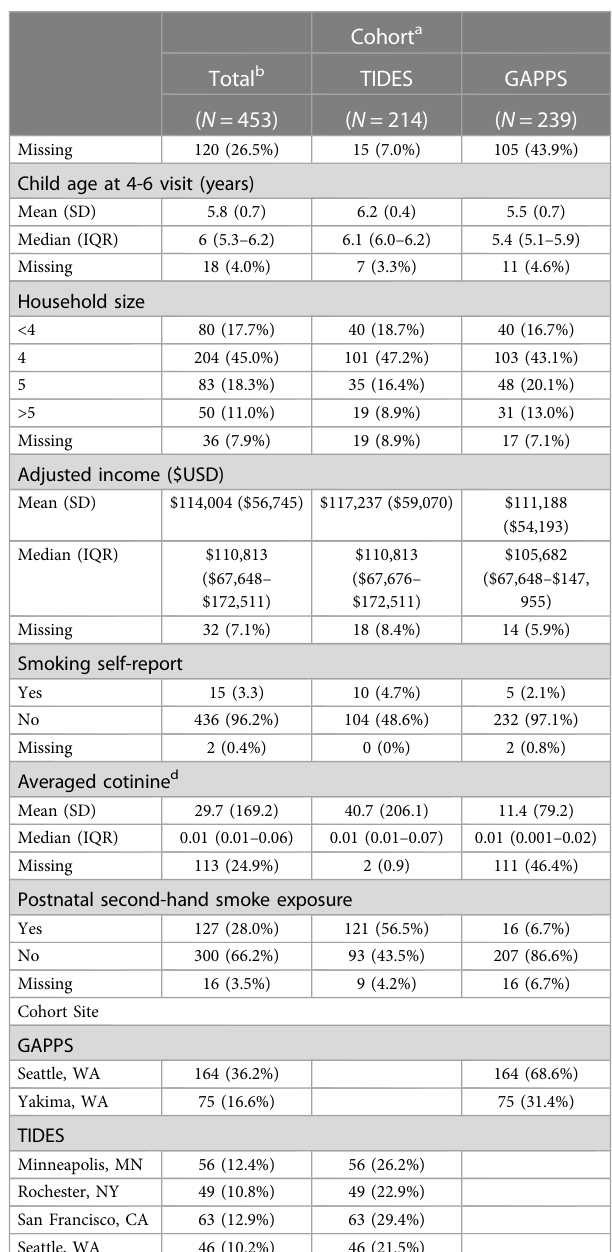
TABLE 1 Descriptive characteristics of the study population by